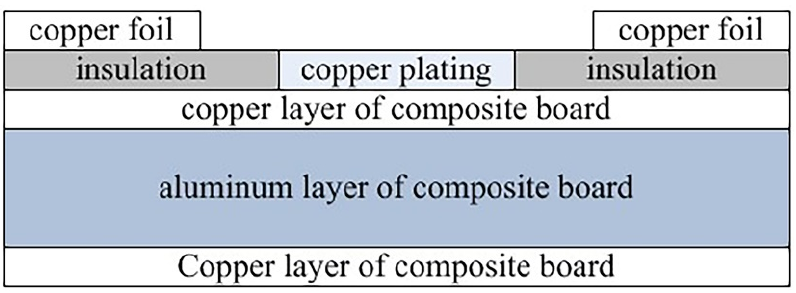
Figure 6. Schematic diagram of composite metal plate.